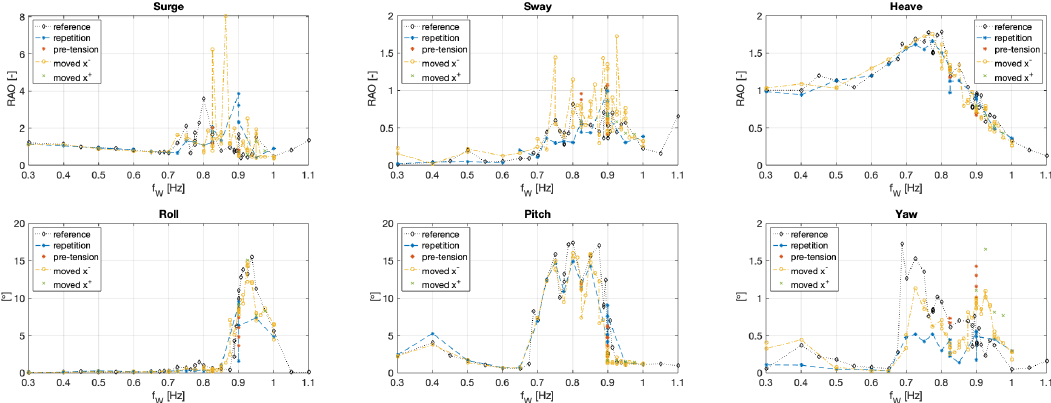
Figure 5. Amplitude response in the six DoF in relation to the requested wave frequency f W .